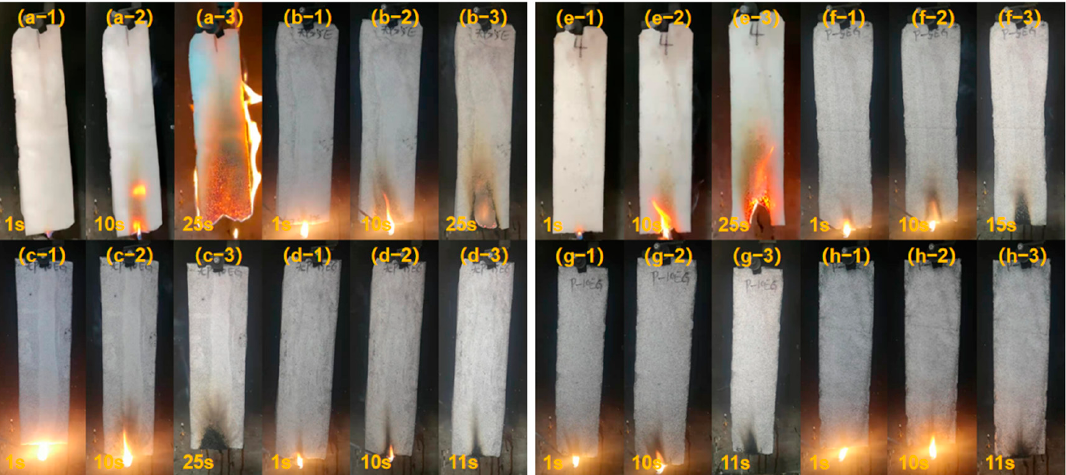
Figure 4. Digital photos of R-FPUF ( a–1 ~ a–3 ), R-FPUF/5EG ( b–1 ~ b–3 ), R-FPUF/10EG ( c–1 ~ c–3 ), R-FPUF/15EG ( d–1 ~ d–3 ), P-FPUF ( e–1 ~ e–3 ), P-FPUF/5EG ( f–1 ~ f–3 ), P-FPUF/10EG ( g–1 ~ g–3 ), P-FPUF/15EG ( h–1 ~ h–3 )at different ignition time. Table 1. The vertical burning test results of R-FPUF and flame-retardant